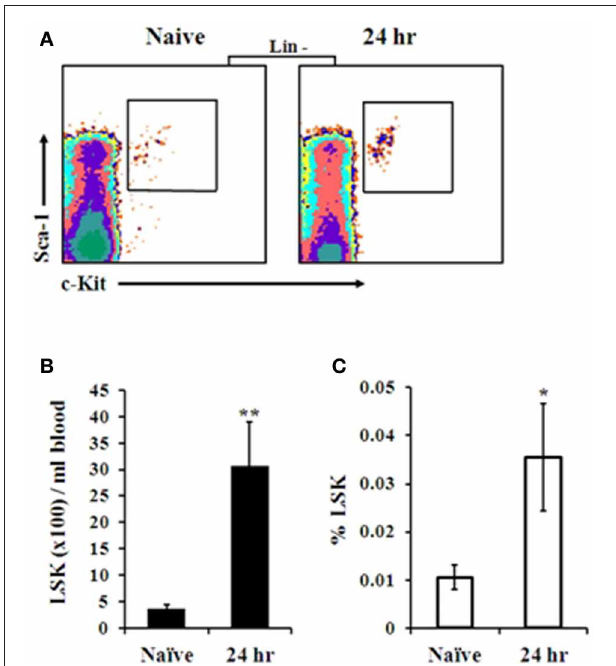
FIGURE 4 | FACS analysis of HSPC levels in the blood following i.n. infection with Y. pestis. (A) Representative FACS plot of gated LSK cells in the blood of naïve vs. infected mice at 24h post infection. The absolute number (B) and percentage (C) of primitive LSK cells per 1ml blood of naïve vs. infected mice (24h post infection) are presented. n = 8–10 mice per group. ∗ p < 0 . 05; ∗∗ p < 0 . 01 compared with naïve